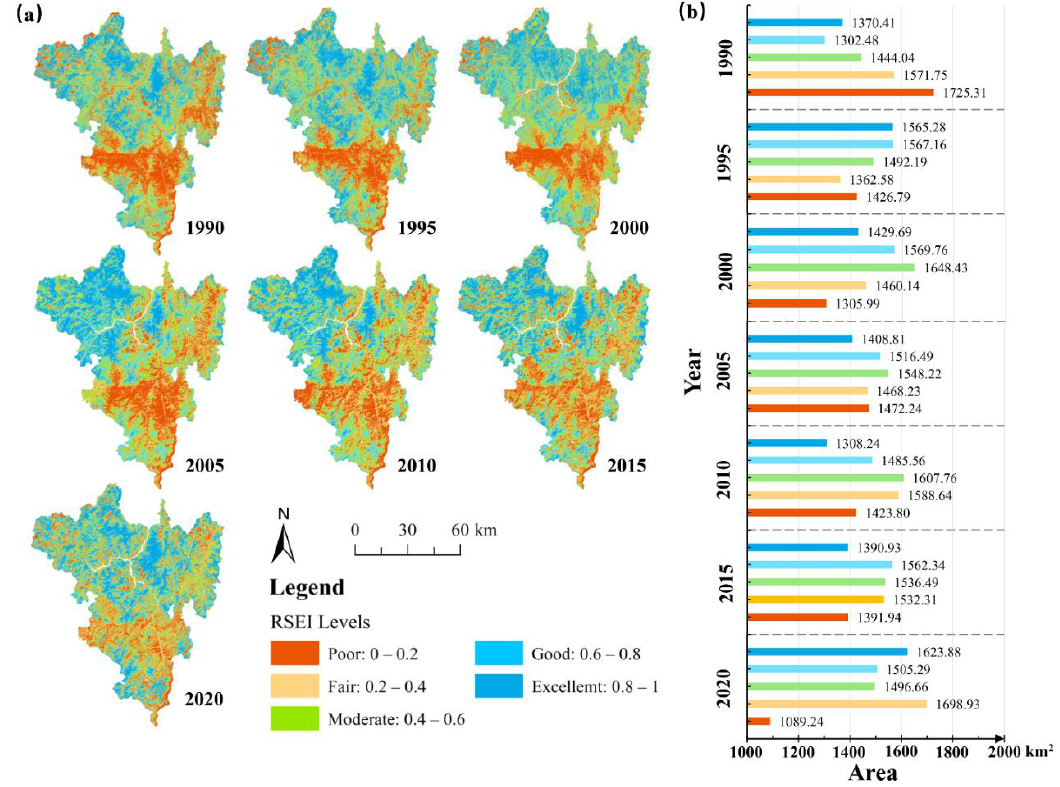
Figure 3. The RSEI Classification Results of Panzhihua City in 1990, 1995, 2000, 2005, 2010, 2015, and 2020. ( a ) Spatial Distribution Map of RSEI. ( b ) Area of RSEI Classification Results.